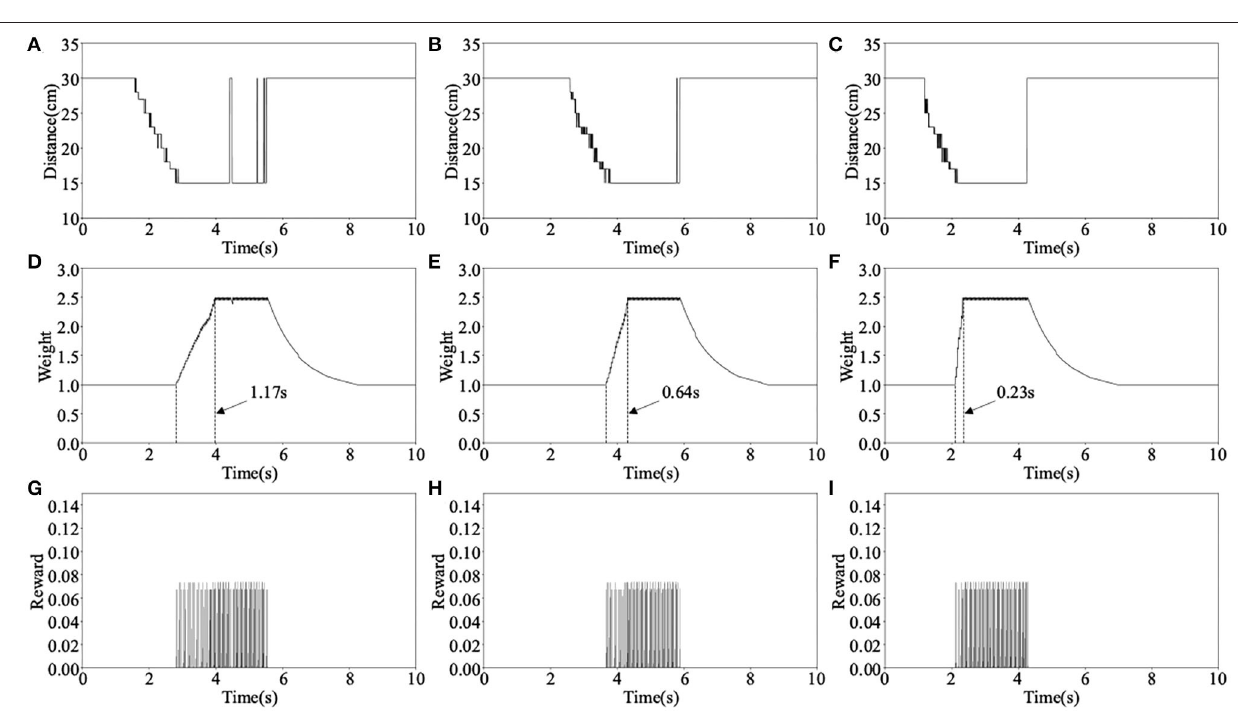
completed its intended task. The changes in the main parameters in this obstacle avoidance process are given in Figure 10 . All these data are collected in real-time from the